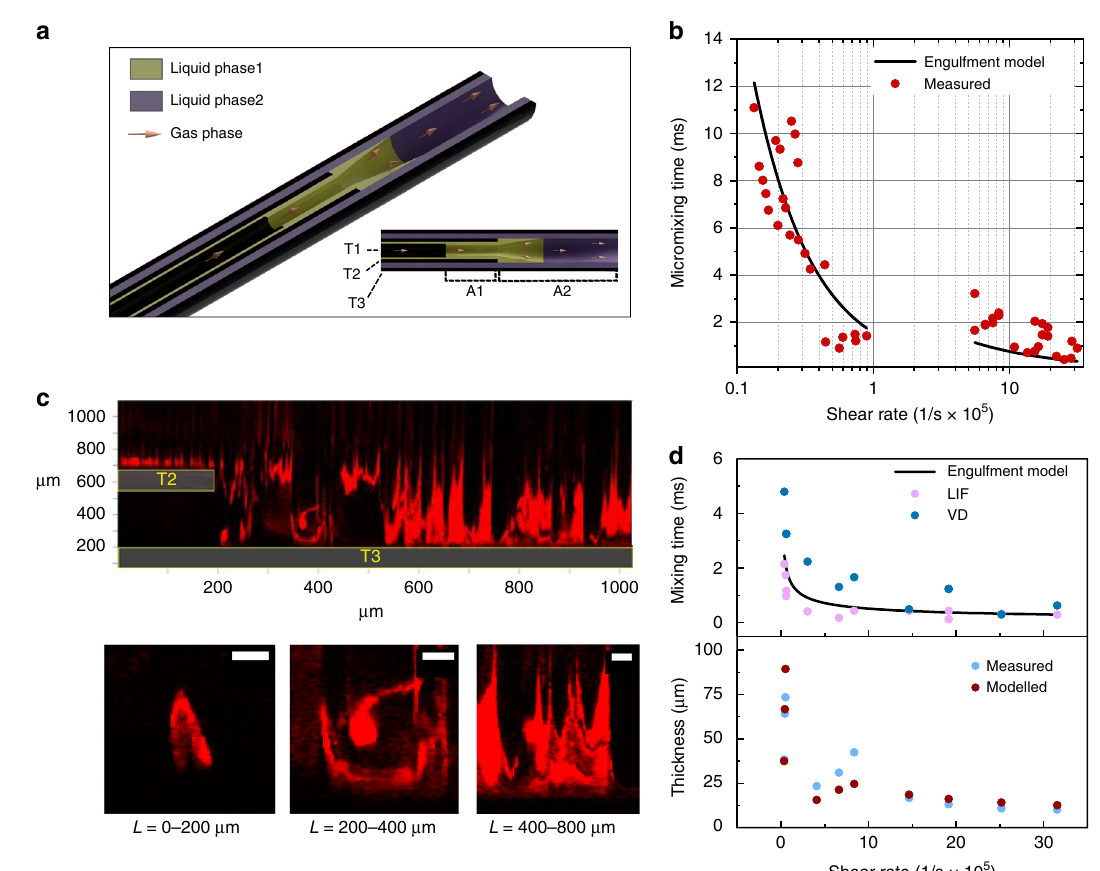
Fig. 1 Annular reactor mixing dynamics. a Schematic of microreactor axial cross-section, where T1, T2, and T3 are the three coaxial tubes, and regions A1 and A2 are the annular fl ow regions created by the fl ow of the gas phase (red arrow). In A2, mixing of phase 1 (yellow) and phase 2 (purple) occur. b Predicted and measured characteristic micromixing times using Villermaux – Dushman test reaction. c High-speed laser induced fl uorescence (LIF) microscopic frames of mixing in the A2 region. Phase 1 (red, laced with fl uorescent tracer) and Phase 2 (blank) fl ow from left to right. At top is half of the axial cross-section, where T2 and T3 are highlighted, showing chaotic mixing over 1 mm. Below are snapshots of vortices along the reactor length, which are initially generated at the edge of T2 (scale bar = 10 µ m). d Measurements and model predictions of macromixing time and fi lm thickness (bottom) in A2 as a function of shear rate. The mixing time calculated from LIF microscopy measurements (LIF) is compared to the mixing times